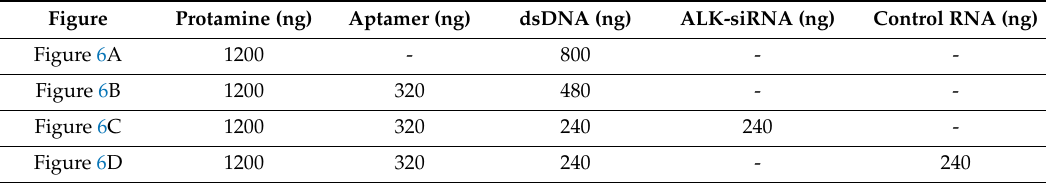
Table 1. Components of protamine